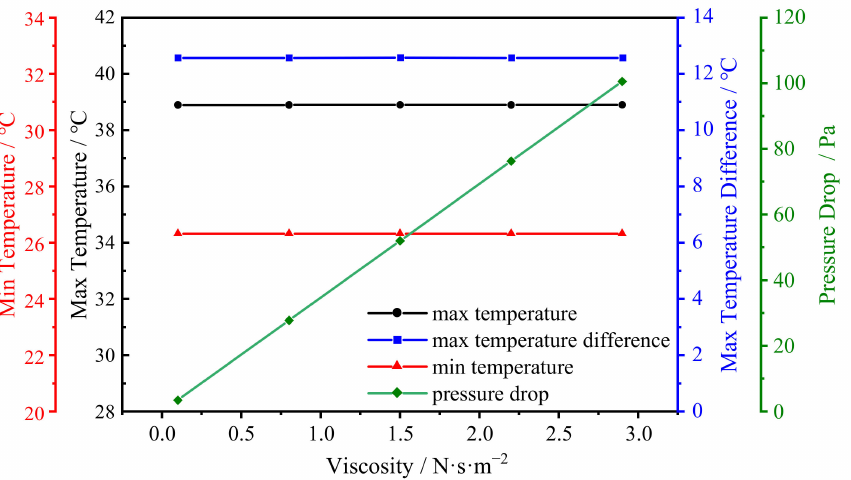
Figure 11. Relationship between the viscosity of the coolant and the MAT, MIT, MATD of the cell, as well as the pressure drop of the